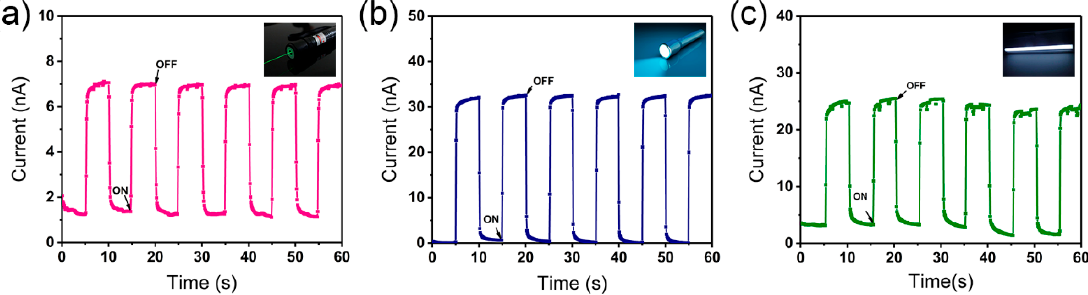
Figure 8. Photoresponse performance under different light sources. ( a ) Laser, ( b ) flashlight, and ( c ) fluorescent lamp.